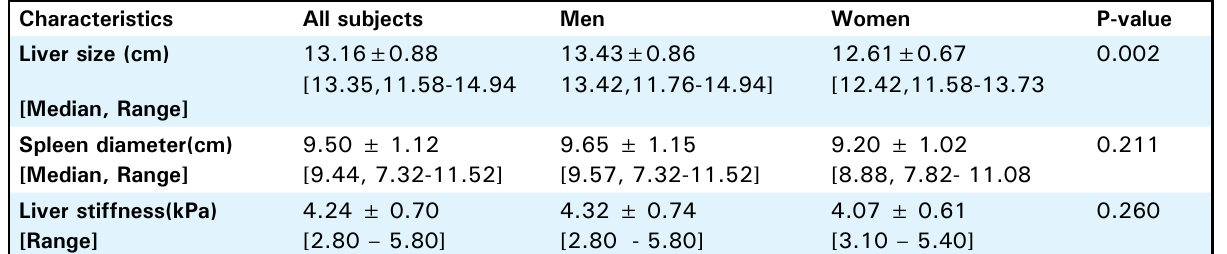
table 3. Ultrasonographic measurements and Fibroscan values of the study subjects.